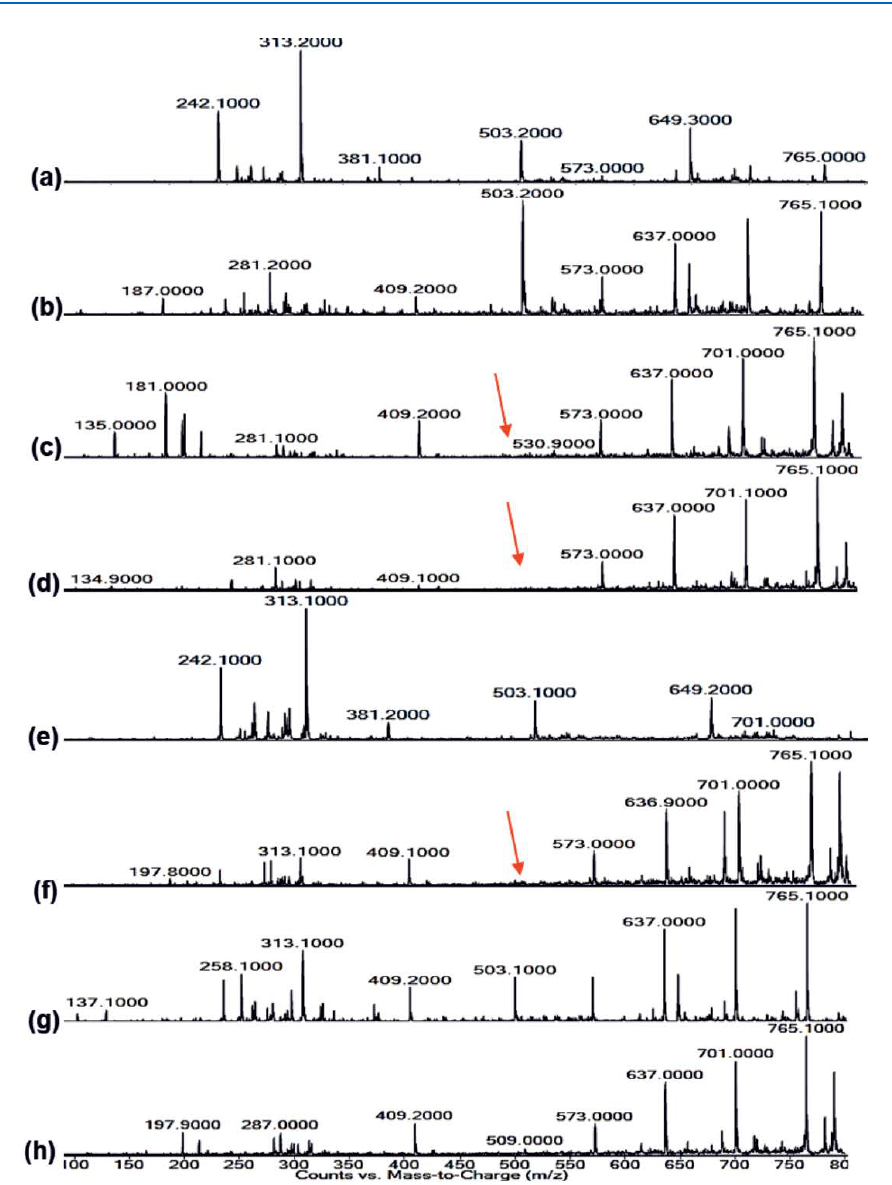
Fig. 9. LC-MS of Rhamnolipid extracted (a) Control, (b) Punica granatum, (c) Citrus reticulata, (d) Vitis amurensis, (e) Carica papaya, (f) Vitis vinifera, (g) Ananas comosus, (h) Ficus